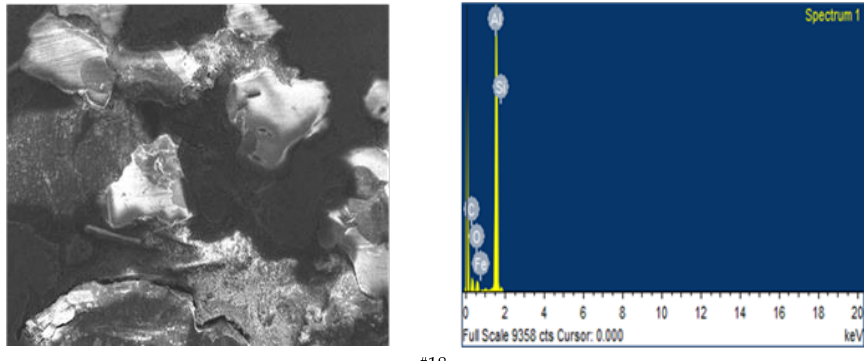
Figure 3. SEM micrograph and EDS spectrum of experiment #16, #17, and #18.